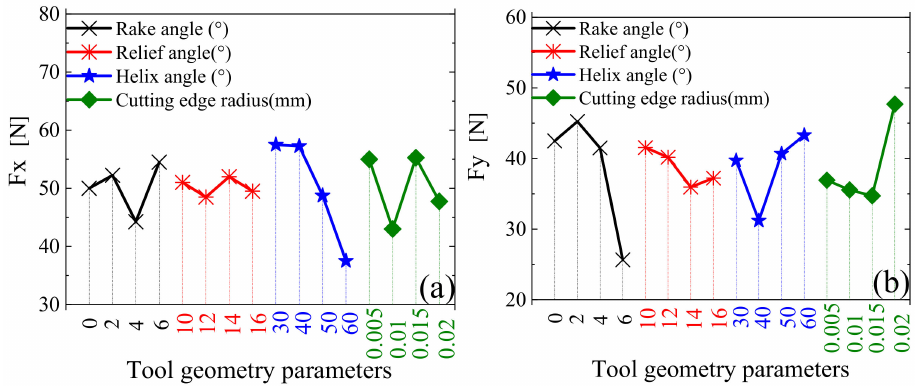
Figure 12. Response relationships between tool geometry parameters and cutting force. ( a ) Cutting force Fx; ( b ) Cutting force Fy.